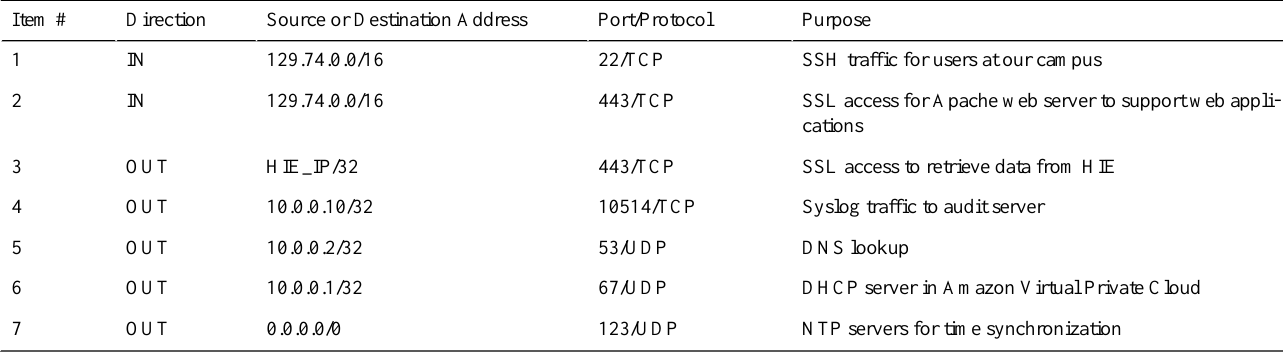
Table 2. Security group for analytics servers.